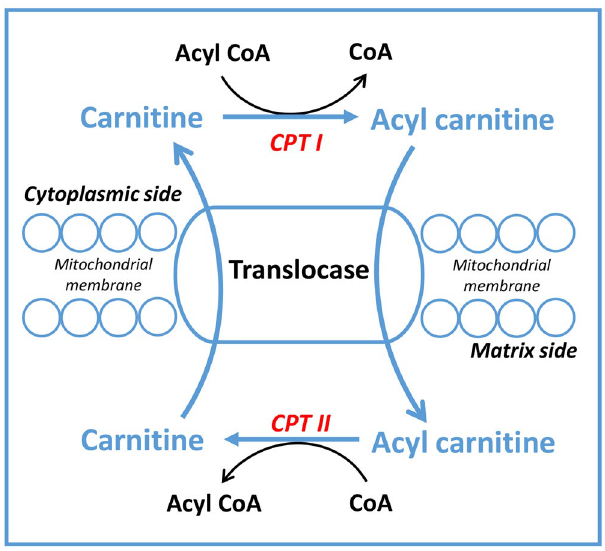
Figure 5. Fatty acid transportation mechanism in the cell. The inner mitochondrial membrane is impermeable to fatty acids and a specialized carnitine carrier system operates to transport activated fatty acids from cytosol to mitochondria. Carnitine is converted to acyl carnitine for fatty acid transportation. The figure was adapted from Nelson et al . 66 . Abbreviations: CoA, coenzyme A; CPT I, Carnitine palmitoyltransferase I; CPT II, Carnitine palmitoyltransferase